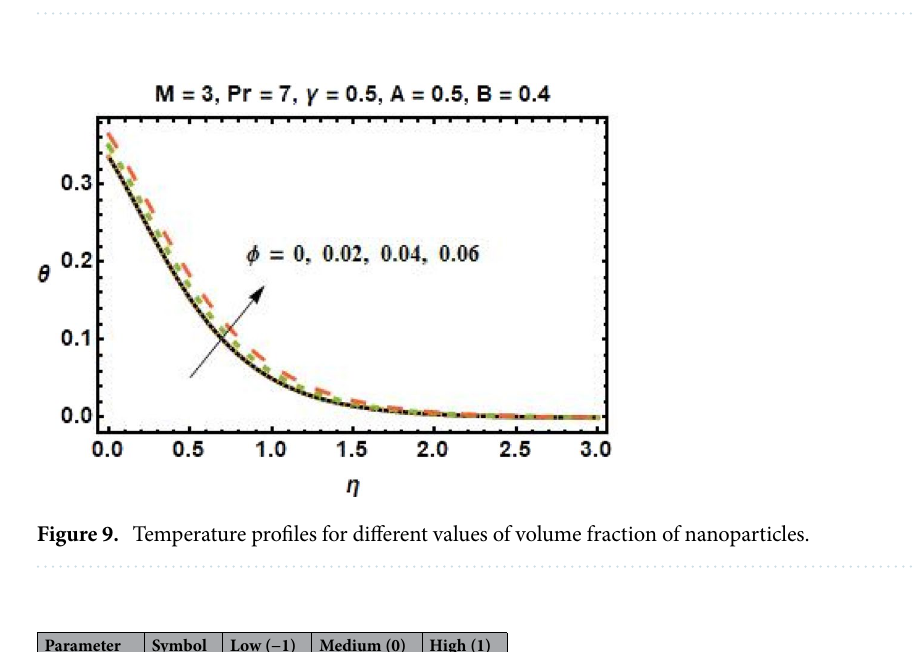
Figure 8. Temperature profiles for different values of the thermal relaxation parameter.